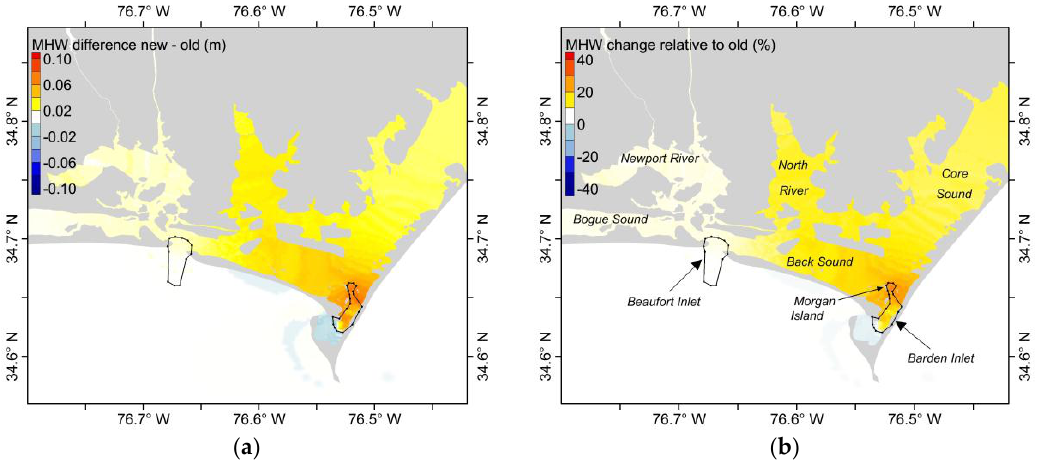
Figure 11. The MHW changes induced only by the inlet morphological changes around Barden Inlet: ( a ) the MHW difference between the new-bathy-BA model and the old-bathy model; ( b ) the MHW change in percentage relative to the old-bathy model MHW. The black dotted polygons delineate the area with changed bathymetry.